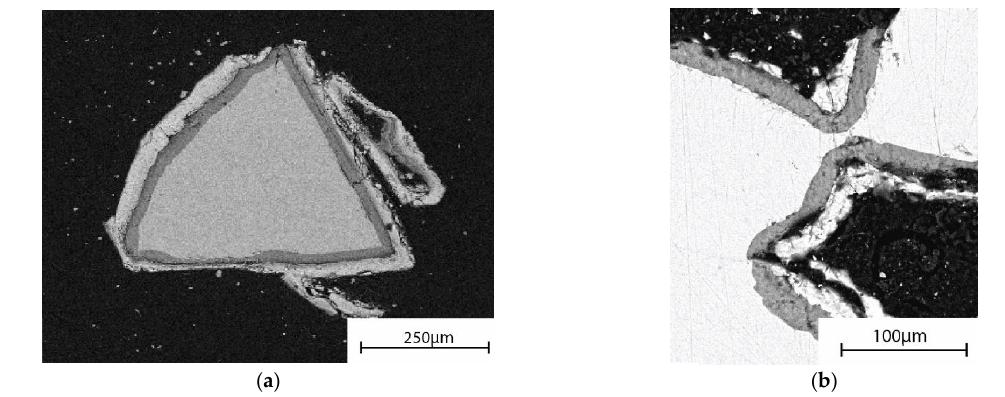
Figure 6. Detailed cross-sectional SEM images of amorphous S53P4 scaffold after 7 days of continuous SBF flow, highlighting ( a ) the different degree of degradation of granules of the same specimen and ( b ) how the CaP layer is reinforcing the necks of the scaffolds. The precipitated CaP layer (seen in white) is surrounding the silica-rich layer (dark grey) on the unreacted glass core (light grey/white).